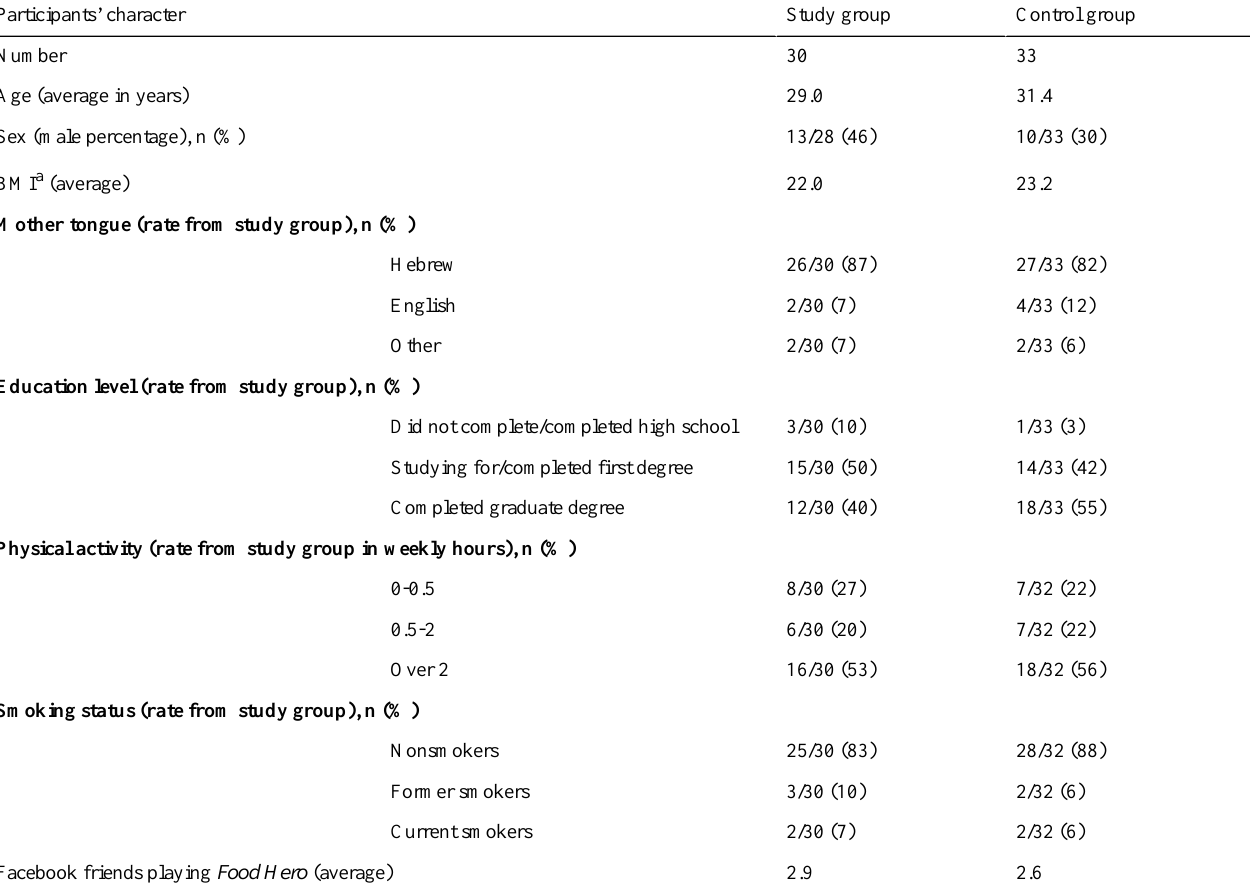
Table 1. Study participants’character by study